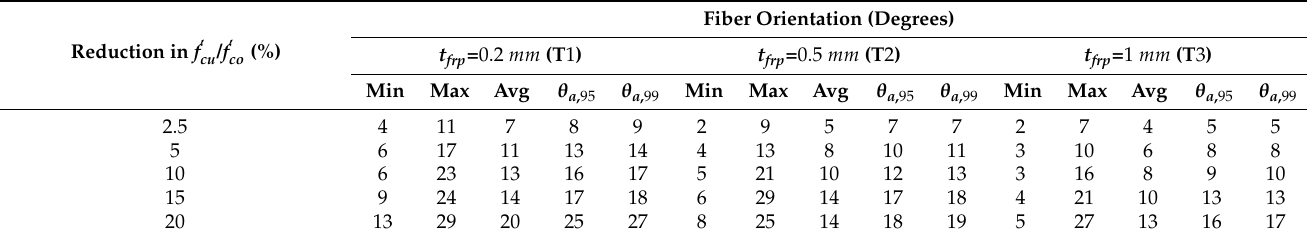
Table 10. Fiber orientations corresponding to different reductions in f (cid:48) cu / f (cid:48) co for each value of f (cid:48) co . Fiber Orientation (Degrees) Reduction in 𝒇 𝒄𝒖(cid:4593) /𝒇 𝒄𝒐(cid:4593) (%)